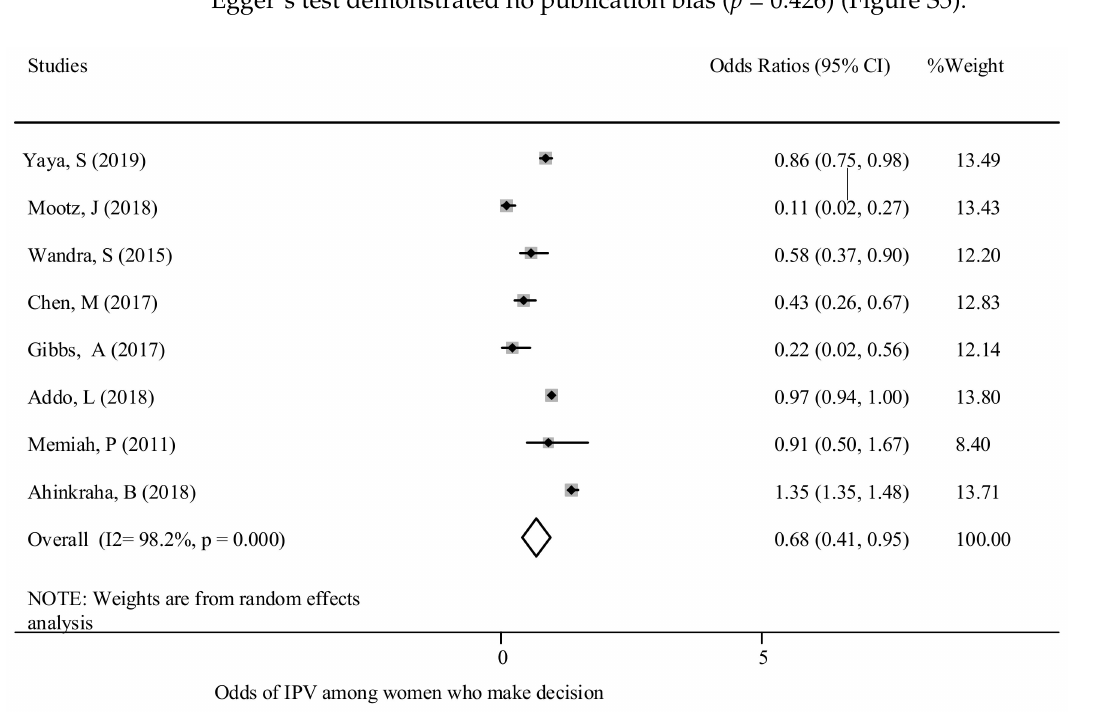
CI (0.41, 0.95)]. Women who have better decision-making skills had a 32% lower chance of